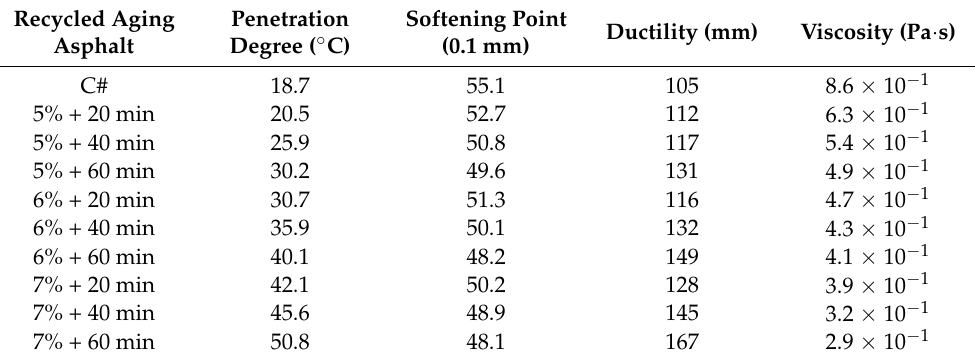
Table 5. Physical performance index of recycled aging